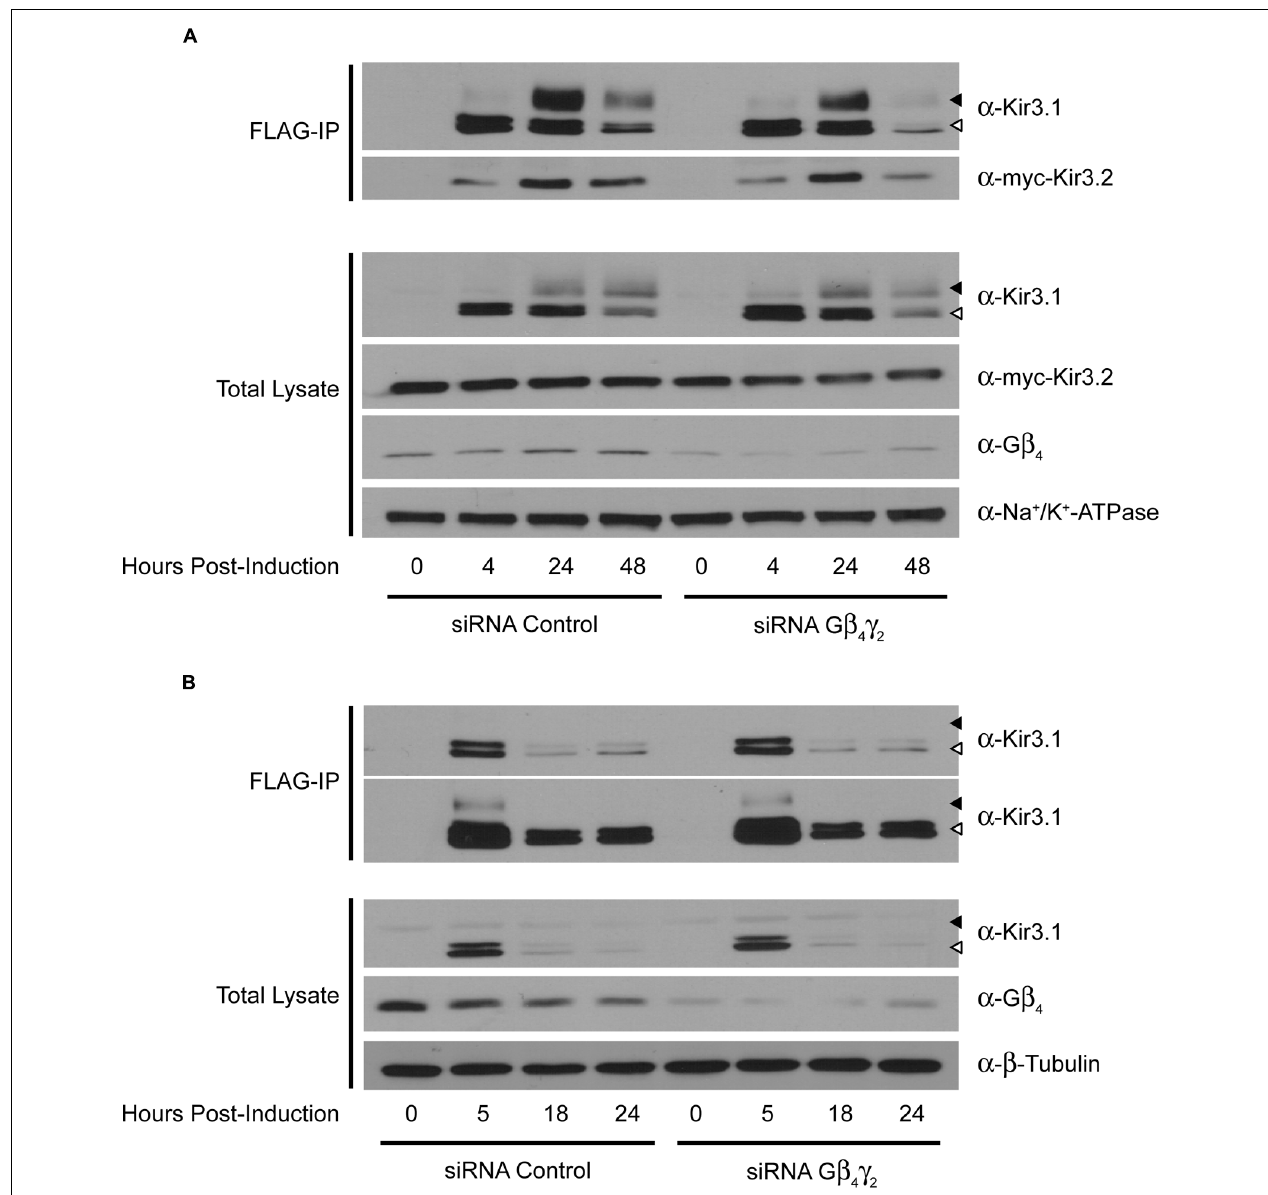
FIGURE 3 | Double knockdown of G β 4 and G γ 2 impairs Kir3.1 stability only in the presence of Kir3.2. (A) Flp-InTrex FLAG-Kir3.1 cells transfected with myc-Kir3.2 and G β 4 /G γ 2 or control siRNA were induced to express FLAG-Kir3.1 with 1 μ g/mL of tetracycline for 30 min and chased for 0, 4, 24, or 48 h. Cells were lysed and FLAG-Kir3.1 was immunoprecipitated as described above. Upper panel: samples were analyzed by western blot to detect levels of FLAG-Kir3.1 and myc-Kir3.2. Lower panel: total cell lysates